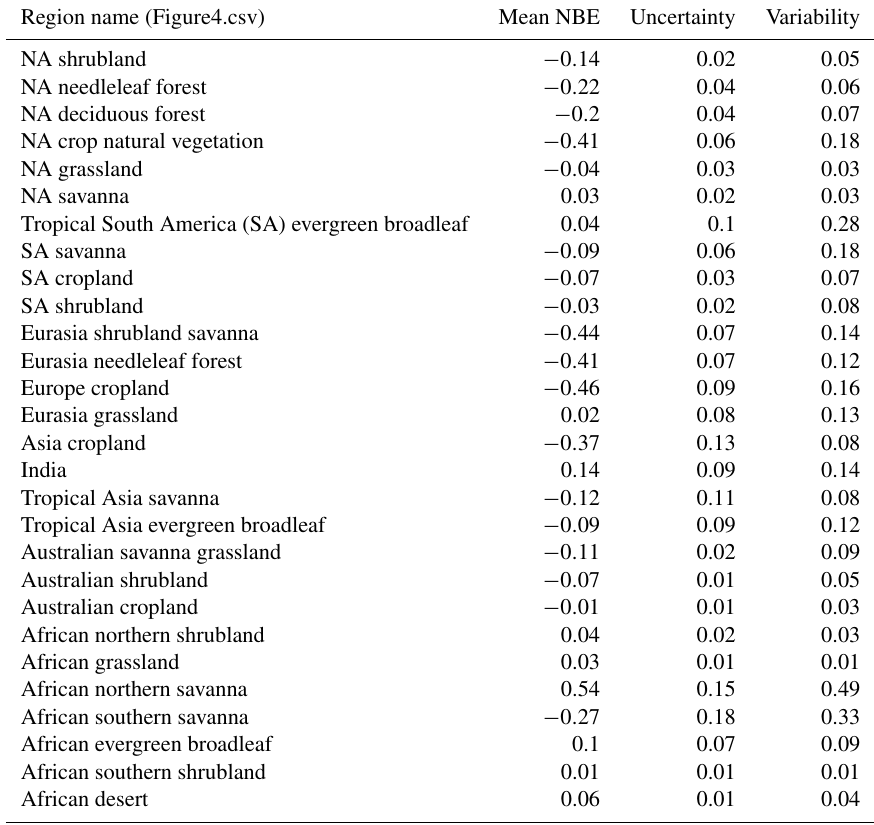
Table 6. The 9-year mean regional annual fluxes, uncertainties, and variability. Regions are based on the mask shown in Fig. 5a (Figure5.csv). Unit: GtC/yr. Region name